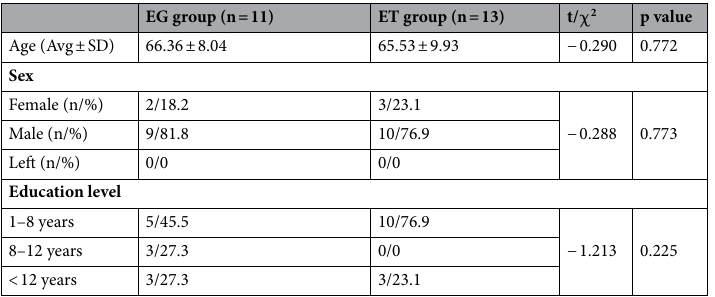
Table 1. Distribution of demographic data. Avg average, SD standard